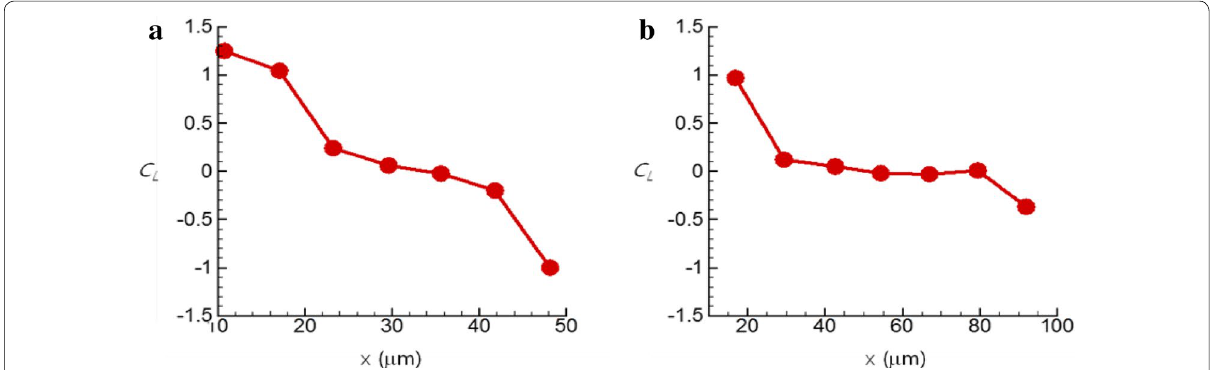
Fig. 6 Variation of x ‑directional force exerted on the particle located at several locations along y